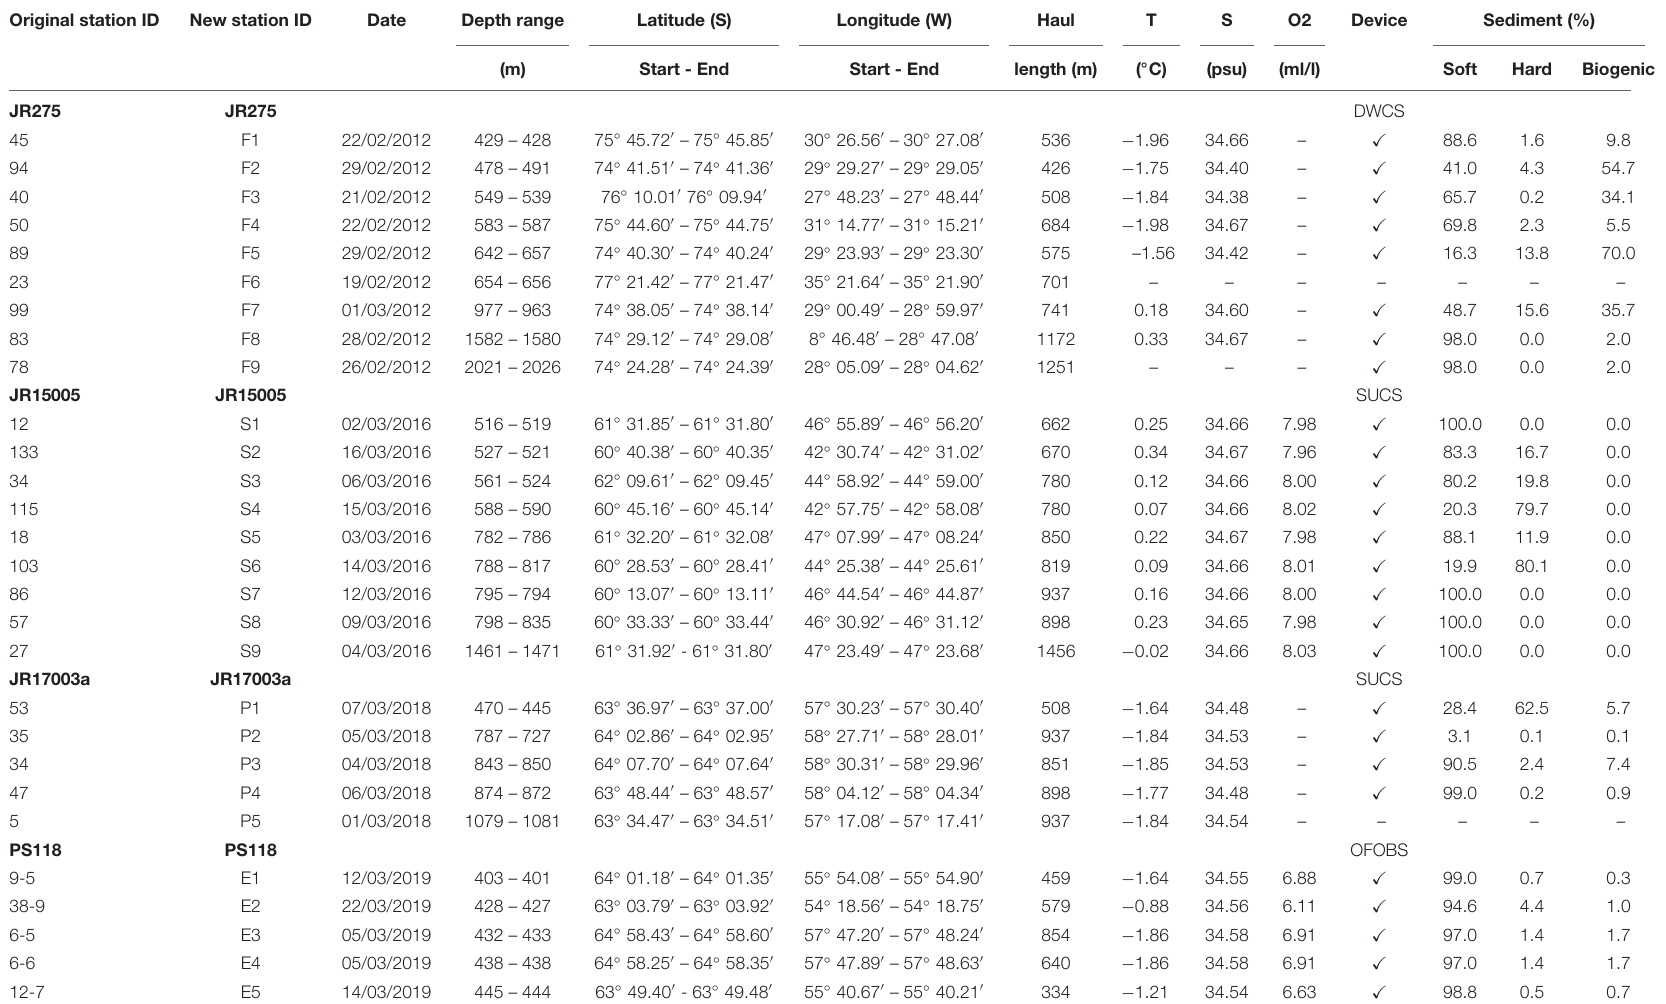
TABLE 1 | Station list of analyzed EBS deployments ordered by depth, CTD and environmental data measured at seafloor. Original station